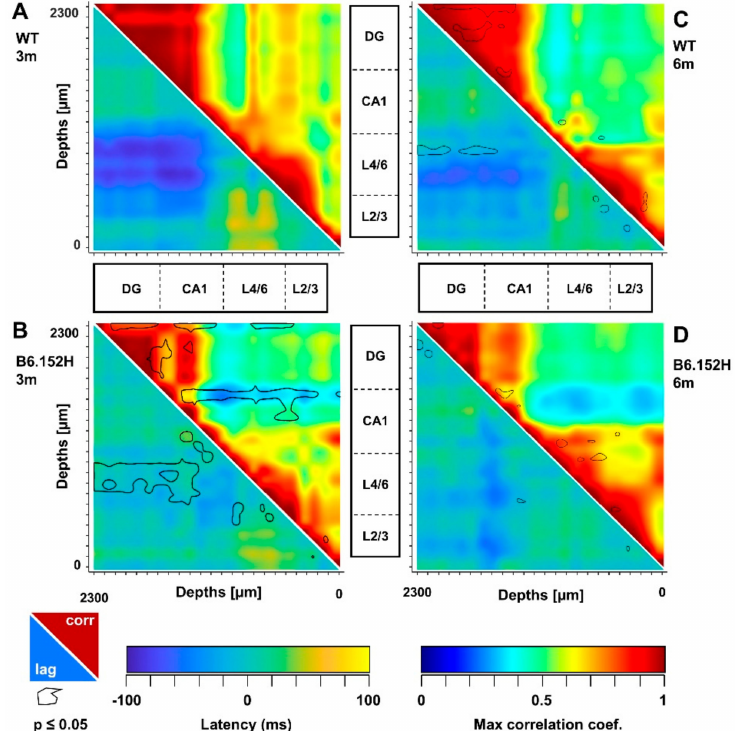
Figure 5. Reduced SO cortico-hippocampal connectivity in young B6.152H mice. SO connectivity was measured in terms of maximal cross-correlation coe ffi cients and latencies of the instantaneous SO amplitude, as described in Supplementary Materials. Matrices of cross-correlation coe ffi cients (upper-right) and latencies (lower-left) for WT ( A , C ) and B6.152H ( B , D ) mice were obtained by comparing each recording channel with all the other channels. The B6.152H matrices report the areas with significant changes with respect to age-matched WT mice ( p < 0.05, black line). In the six-month-old WT matrices ( C ), the comparison is with three-month-old WT mice in panel